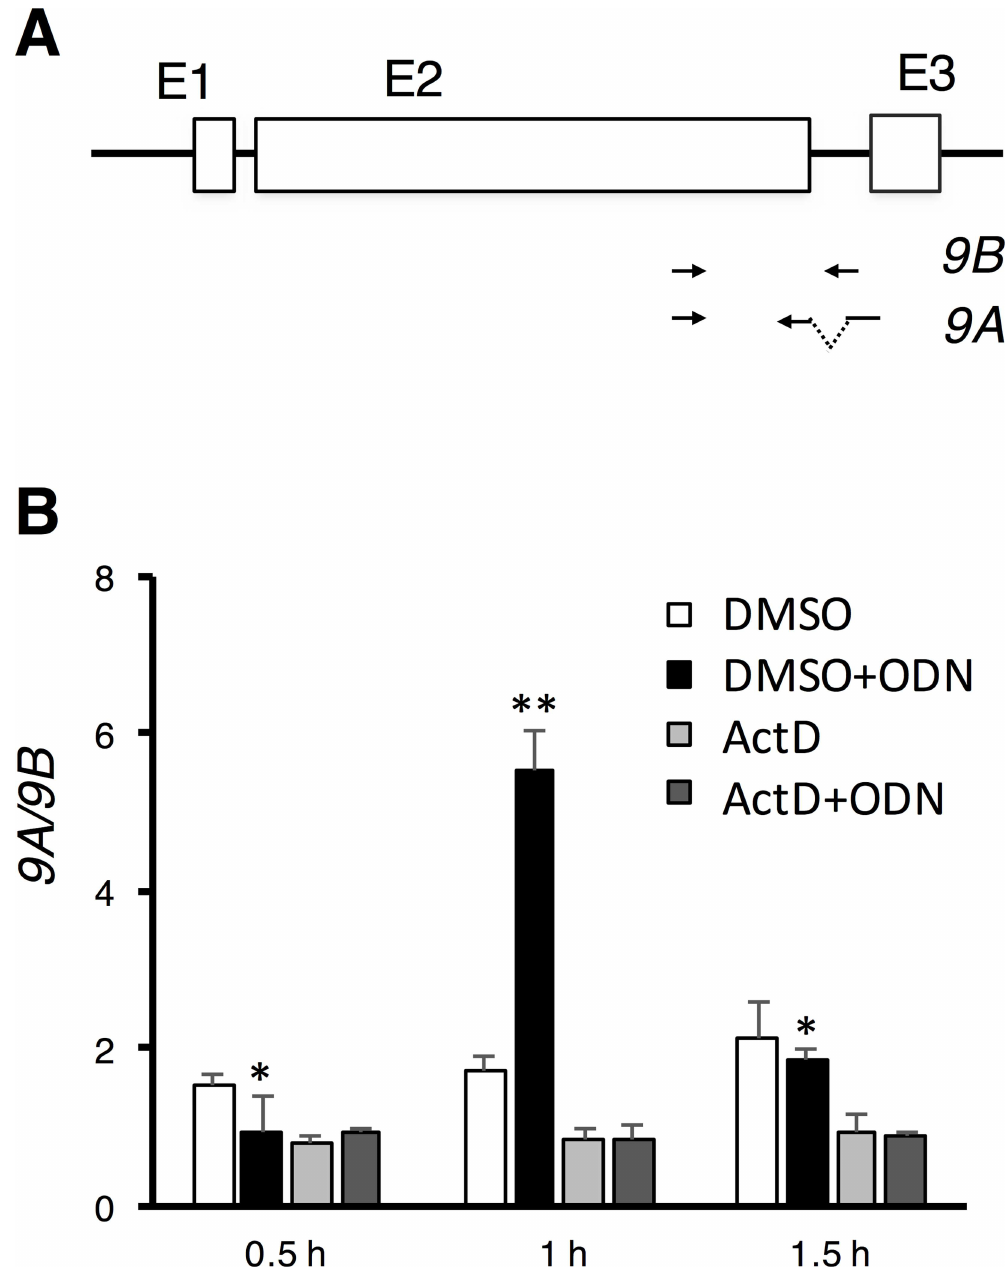
Fig 1. gTlr9 alternative splicing requires active transcription. ( A ) The gTlr9 gene is consisted of three exons (E1, E2, and E3) separated by two introns. Oligonucleotide primer pairs used to specificallyamplify 9A and 9B are illustratedbelow. ( B ) Actinomycin D (ActD) shutdown of transcription abolished ligand-induced gTlr9 alternative splicing. DMSO, solvent for dissolvingActD; ODN, stimulation ligand. The 9A / 9B ratio was calculated by first normalizing 9A and 9B values against that of the ß-actin transcript. Upon ODN stimulation,the 9A / 9B ratio initially increased(~1 h) but then dropped(Cf. black bars and white bars at all three time points). In contrast, under ActD inhibition,the 9A / 9B ratio remained the same. Results are presented as the mean ± SD (n = 3). Student’s t-test, 0.01 < p < 0.05 ( * ) and p < 0.01 ( ** ).